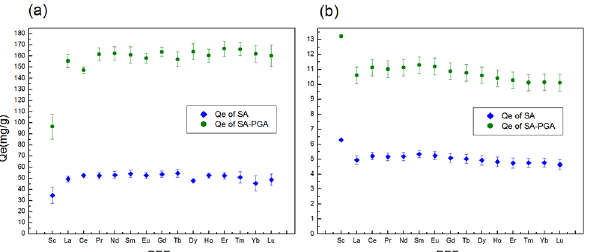
Fig 2. Selective adsorption experiments of REEs: (a) single solution, (b) mixed